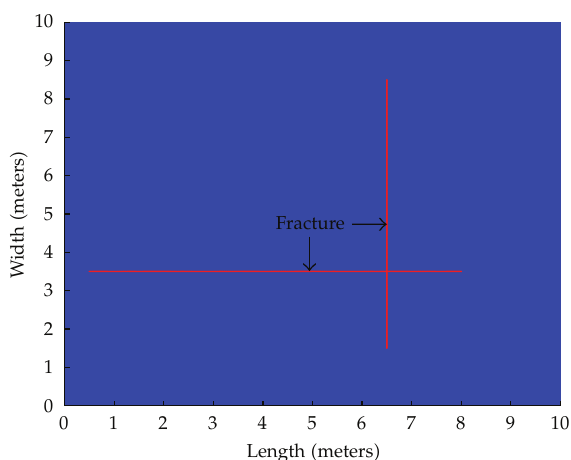
Figure 4: Distribution of fractures: Example 2.